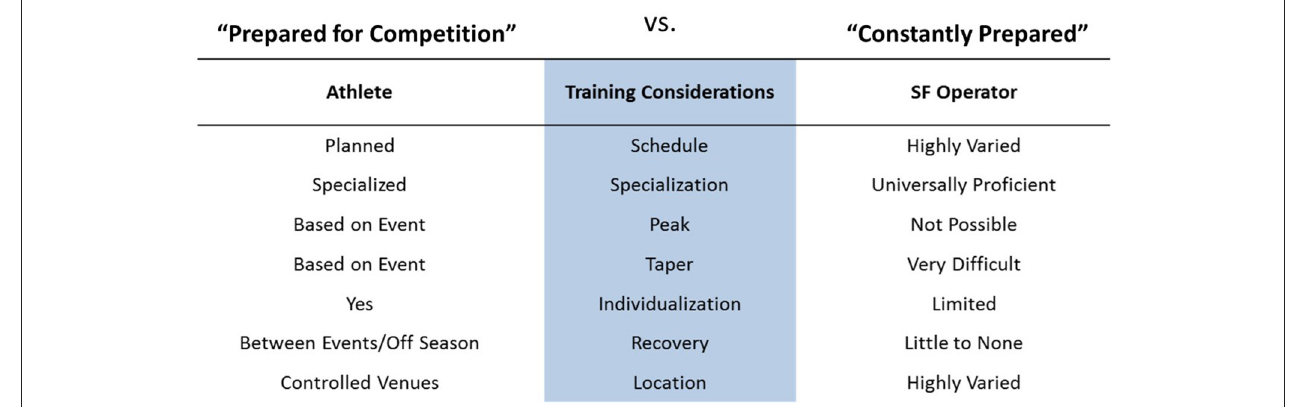
FIGURE 1 | Summary of the differences regarding training between elite athletes and SOF operators. Adapted from Solberg